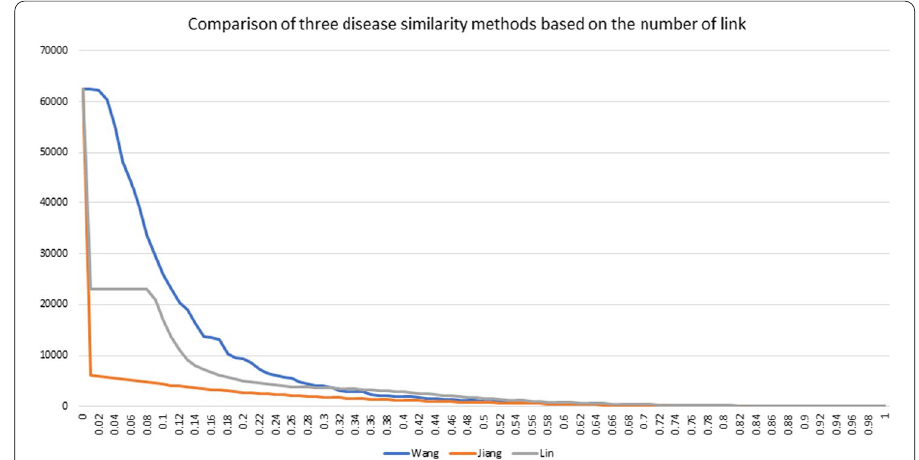
Fig. 1 Comparison of three similar Disease Methods based on the number of links, x-axis indicates the threshold and y-axis indicates the number link